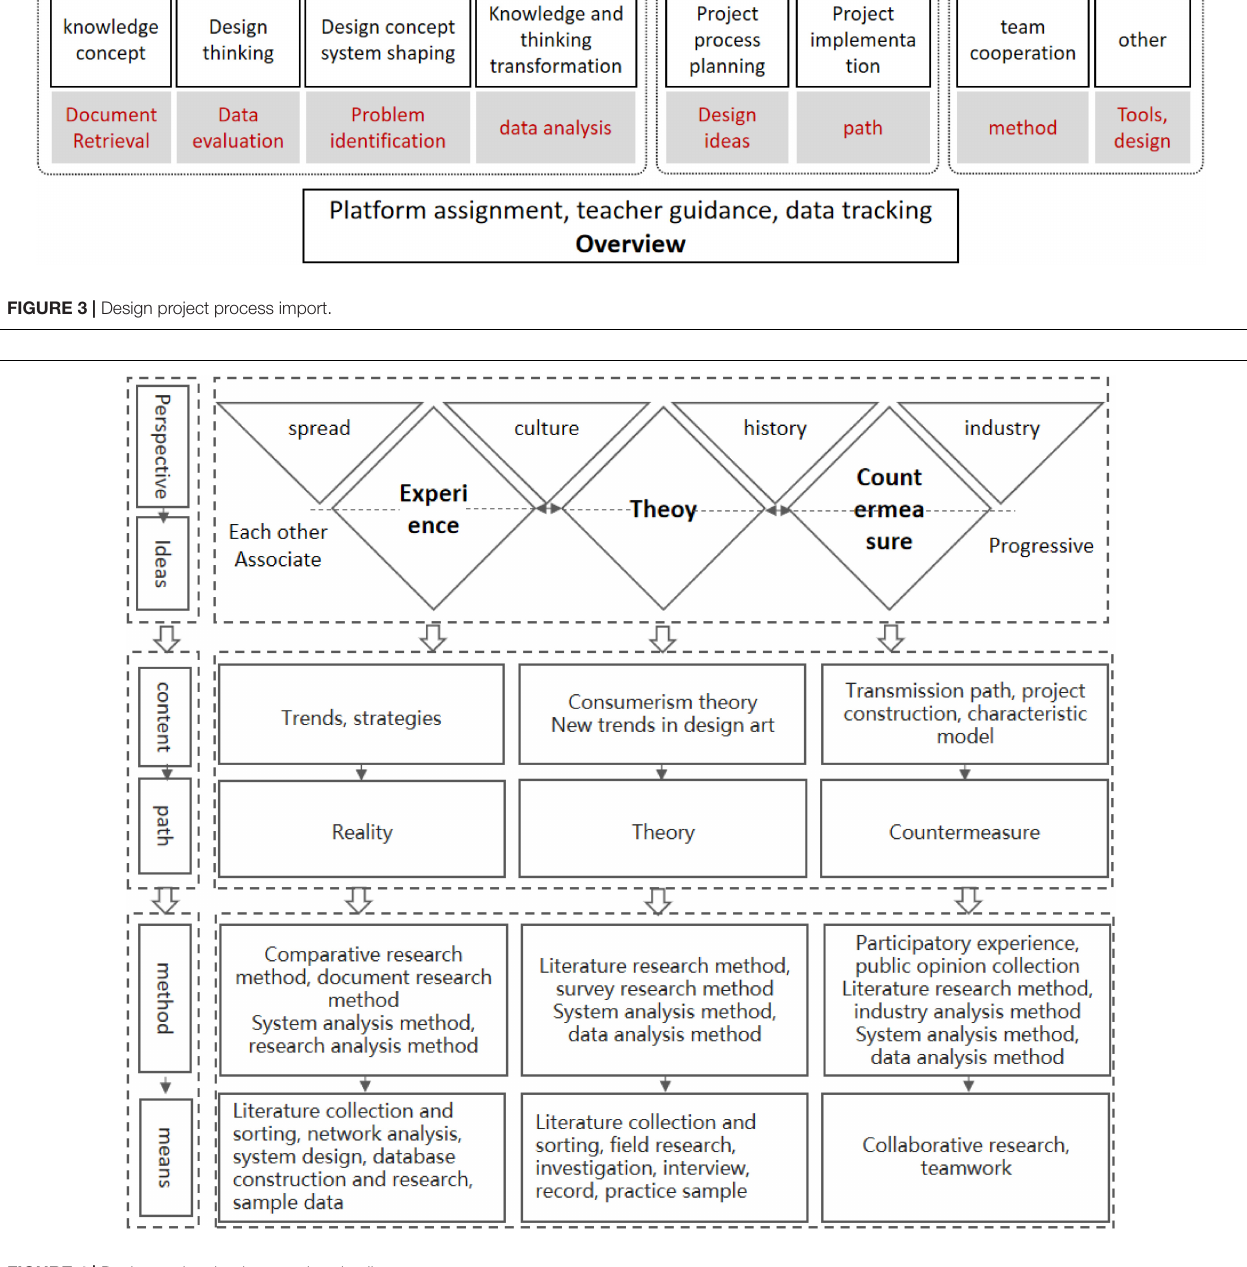
FIGURE 4 | Design project implementation